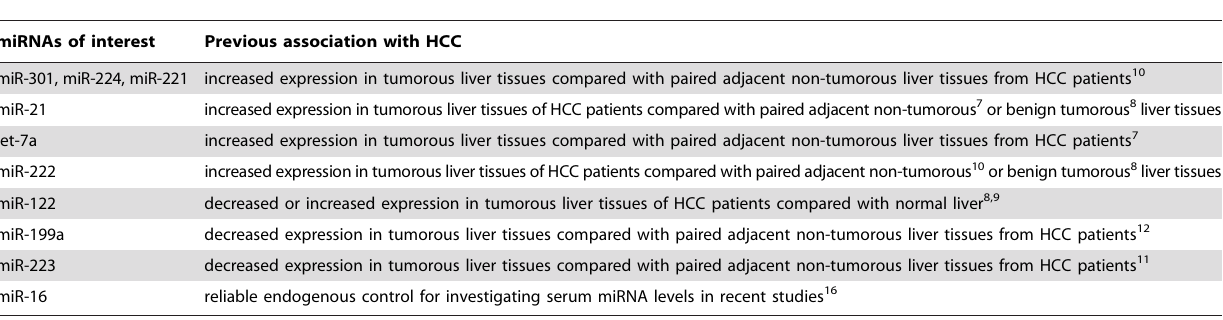
Table 2. Candidate miRNAs for investigation in the circulation of HCC patients.